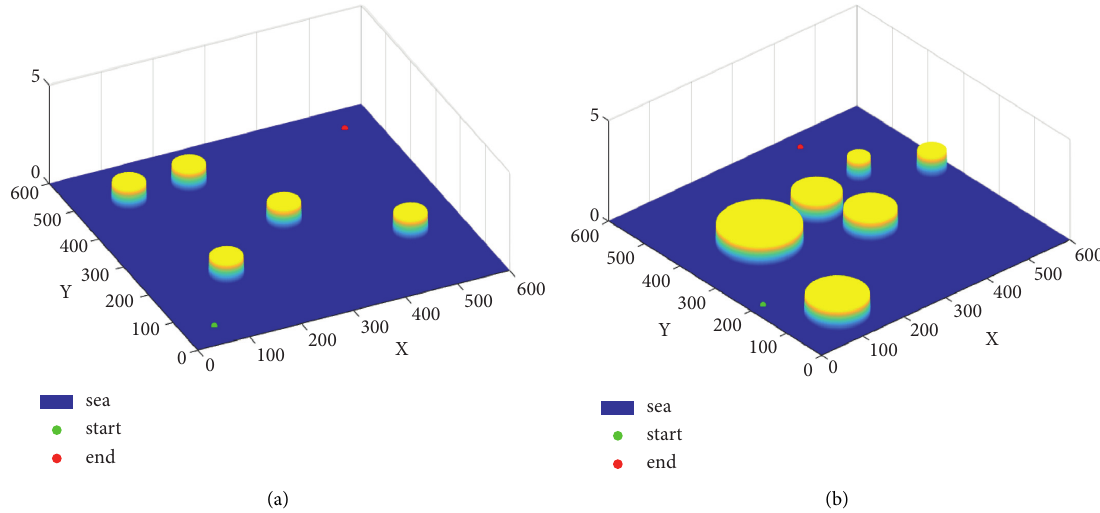
Figure 16: Environments with different levels of complexity. (a) Environment 1. (b) Environment